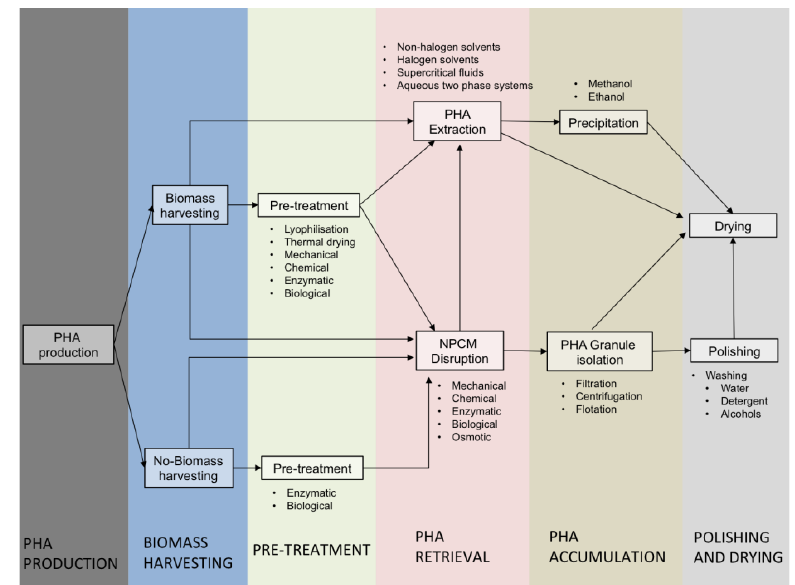
Figure 2 . PHA recovery strategies. Figure 2. PHA recovery